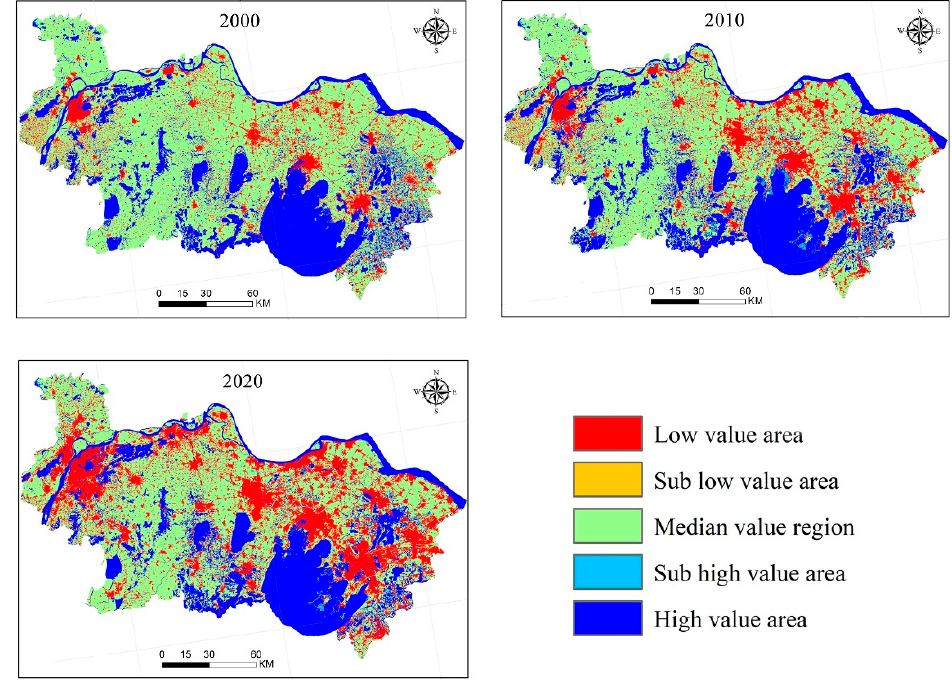
Figure 6. Spatial distribution of ecosystem service values in southern Jiangsu from 2000 to 2020.